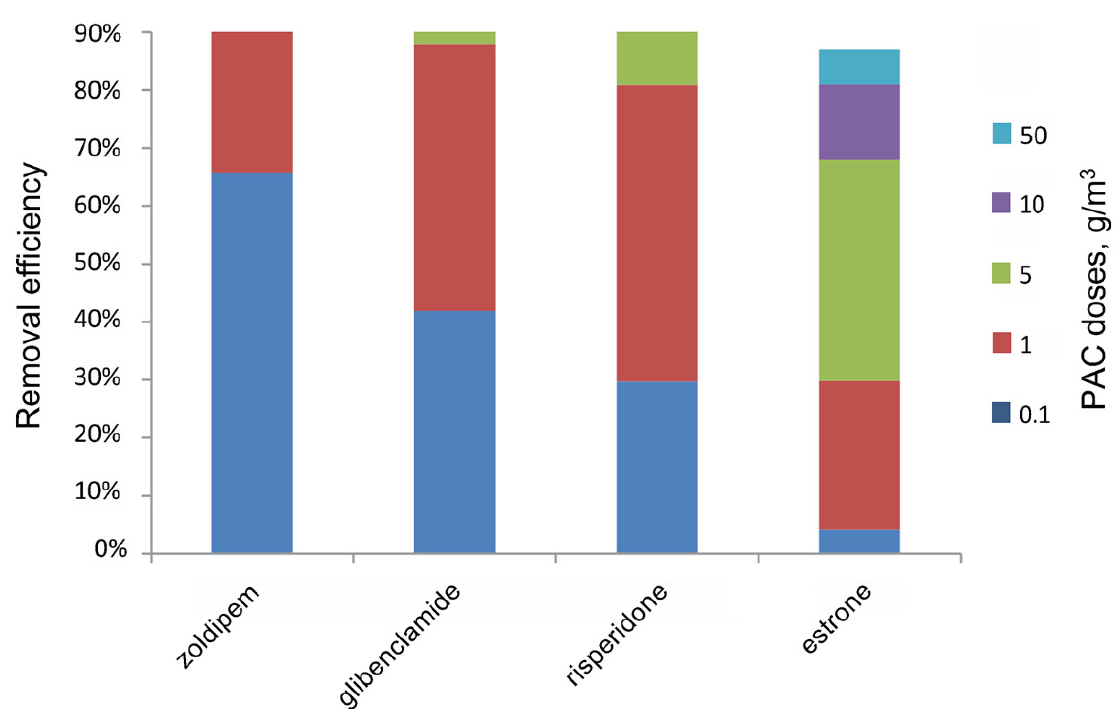
Figure 3. Amount of PAC needed in order to reach 90% reduction of the pharmaceuticals present in the range of 10–100 ng/L in wastewater effluents.